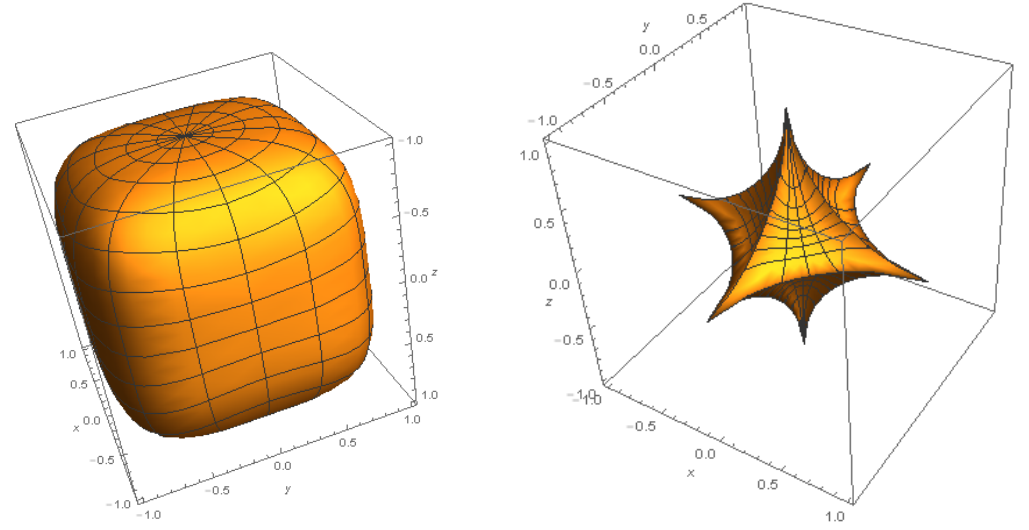
Figure 8: model class 7. left: contour surface of the density in the case p = 4 . right: contour surface in the case p = 0.6